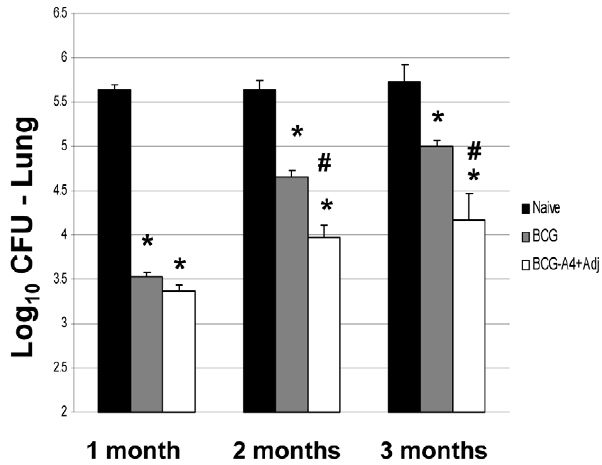
Figure 1. Protection in C57BL/6 mice against a M.tuberculsosis Erdman aerosol challenge after vaccination with either BCG or the D mmaA4 BCG/adjuvant formulation. Mice were challenged with M. tuberculosis 8 weeks after a single s.c. immunization and then were sacrificed 1, 2 or 4 months after the challenge for enumeration of CFU’s in the lung. Significant CFU reduction relative to * naı¨ve mice ( p , 0.05) or # BCG-vaccinated controls ( p , 0.05).